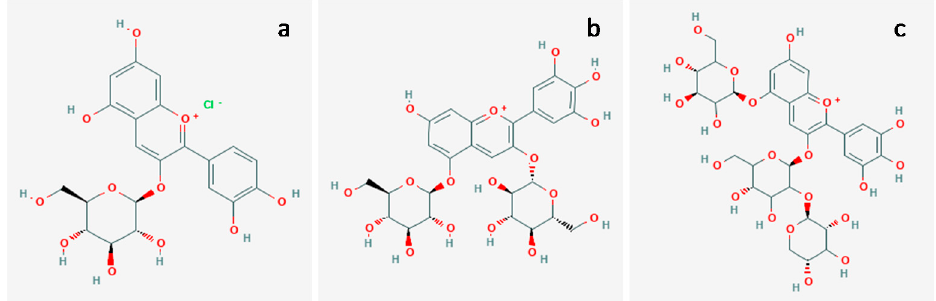
Figure 9. Anthocyanins: ( a ) cyanidin-3- O -glucoside from blackberry [PubChem CID441667], ( b ) delphinidin-3,5- O -glucoside [PubChem CID101100906] and ( c ) delphinidin-3-sambubioside-5- glucoside from maqui [PubChem CID44256891].